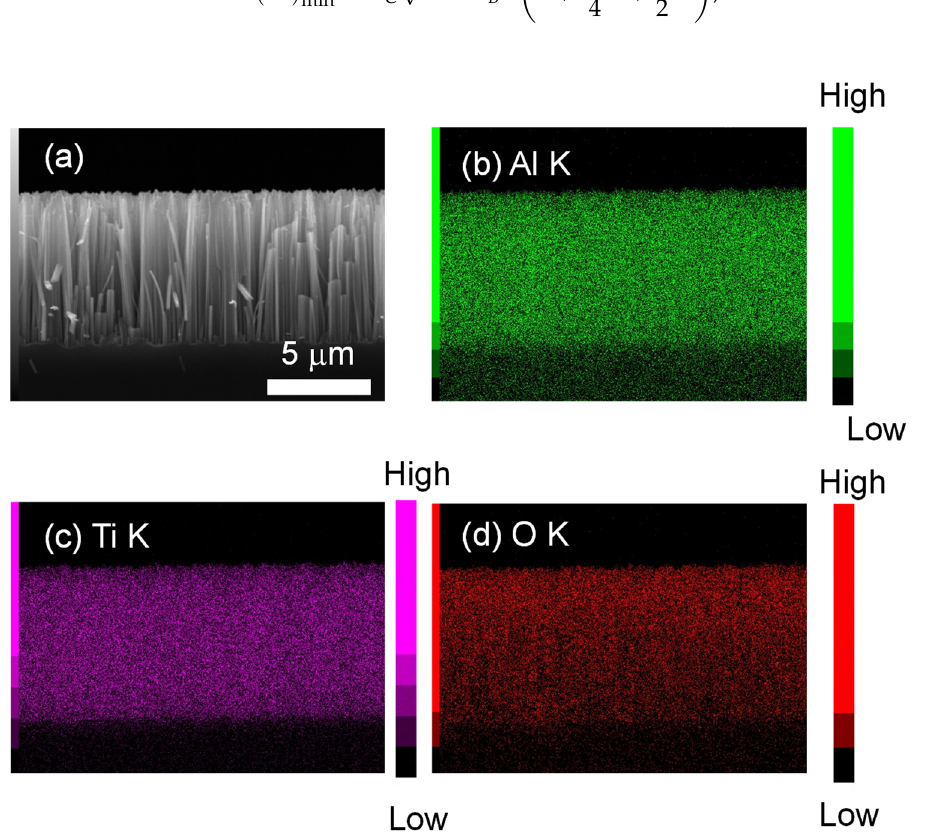
Figure 2. ( a ) Cross-sectional SEM image of a SiNW array coated with ATA. The SiNW array was prepared by MACE for 15 min. The length of SiNWs is 8 μ m, ( b ) EDS mappings of Si K, ( c ) Al K, ( d ) Ti K signal.